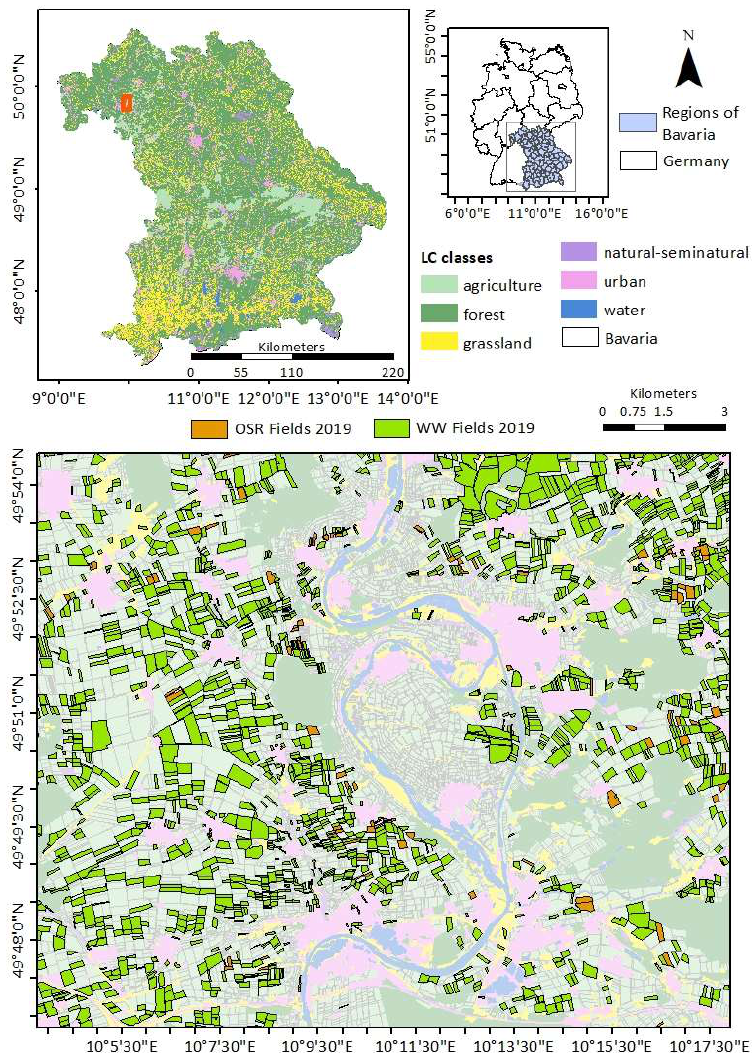
Figure 2. An overview of the study region. The LC map of Bavaria is obtained by combining multiple inputs of Landcover maps, such as Amtliche Topographisch-Kartographisches Informationssystem, Integrated Administration Control System (provides the crop field information), and Corine LC, into one map. Agriculture (peach green) dominates mainly in the northwest and southeast of Bavaria, while forest and grassland classes (dark green and yellow, respectively)